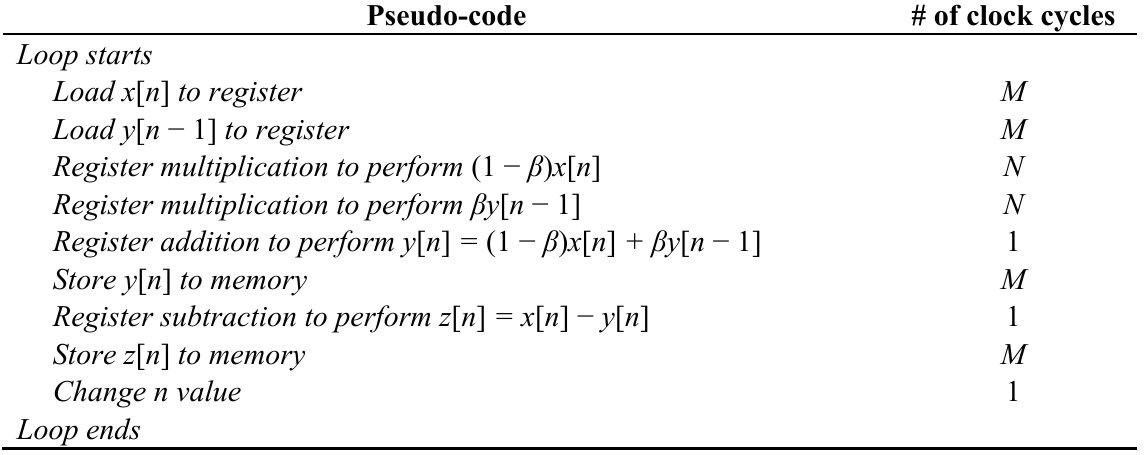
Table 1. Pseudo-code of PVVE algorithm (digital section